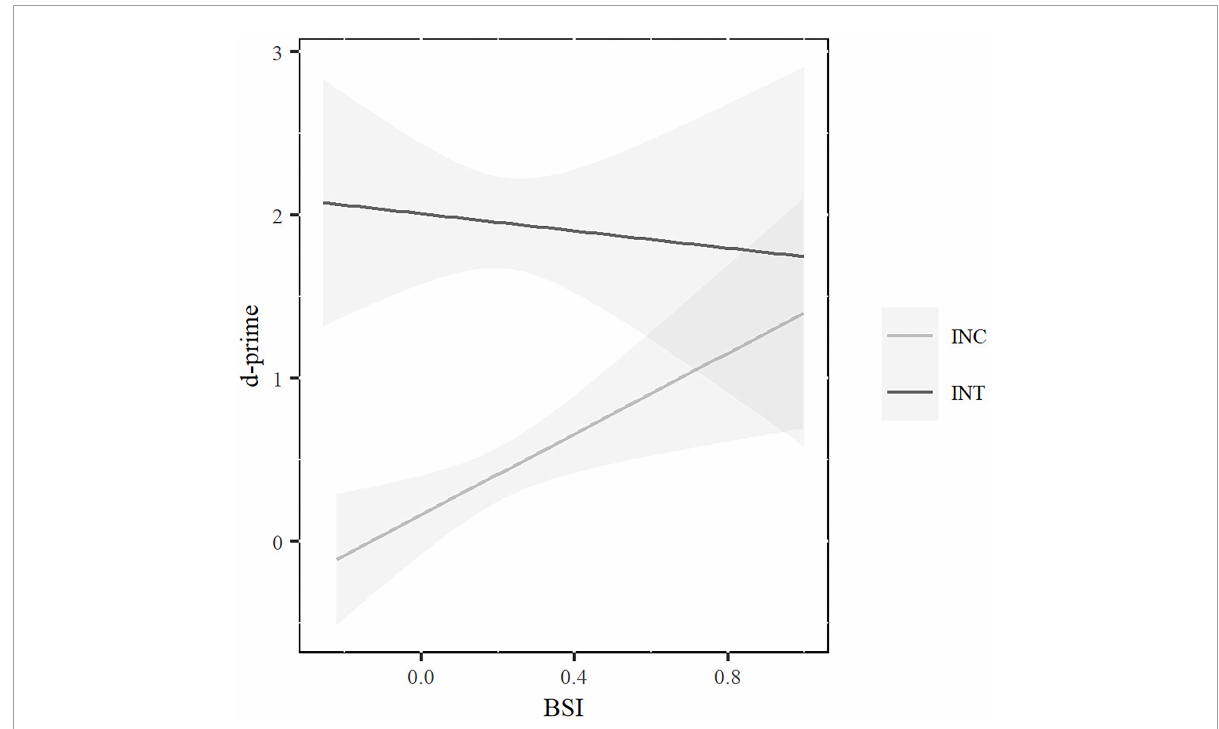
FIGURE2 Rule-learning d’ scores associated to BSI for incidental (INC) and intentional (INT) conditions. Highlighted areas represent standard error.